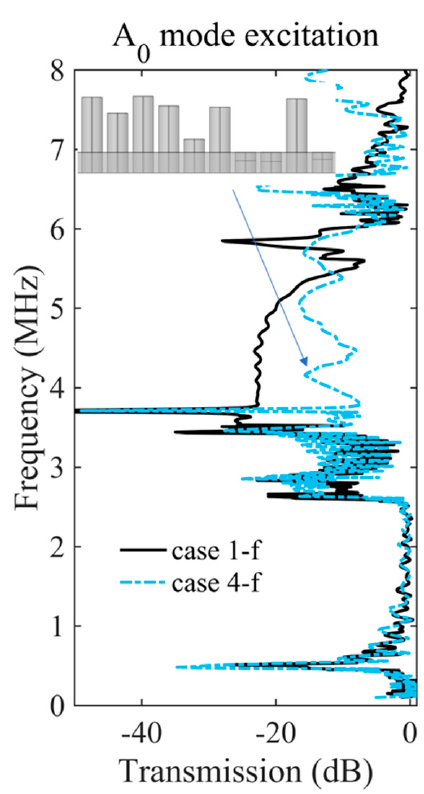
Figure 8. A 0 Lamb mode excitation. The forward ( − f) transmission curves of Cases 1 and 4 of the asymmetric part, where Case 4 is a disorder profile of pillars and blind holes in the plate as shown in the inset.